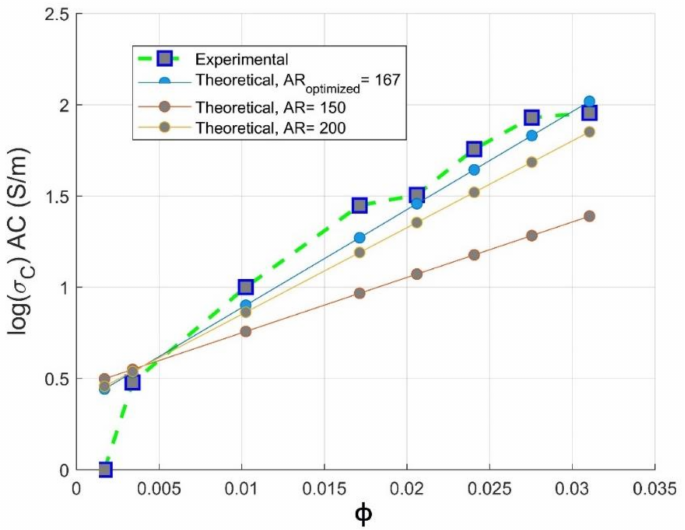
Figure 12. Comparative theoretical and experimental plots of conductivity against volume fraction of CNTs based on the Mamunya model for different aspect ratio for CNT